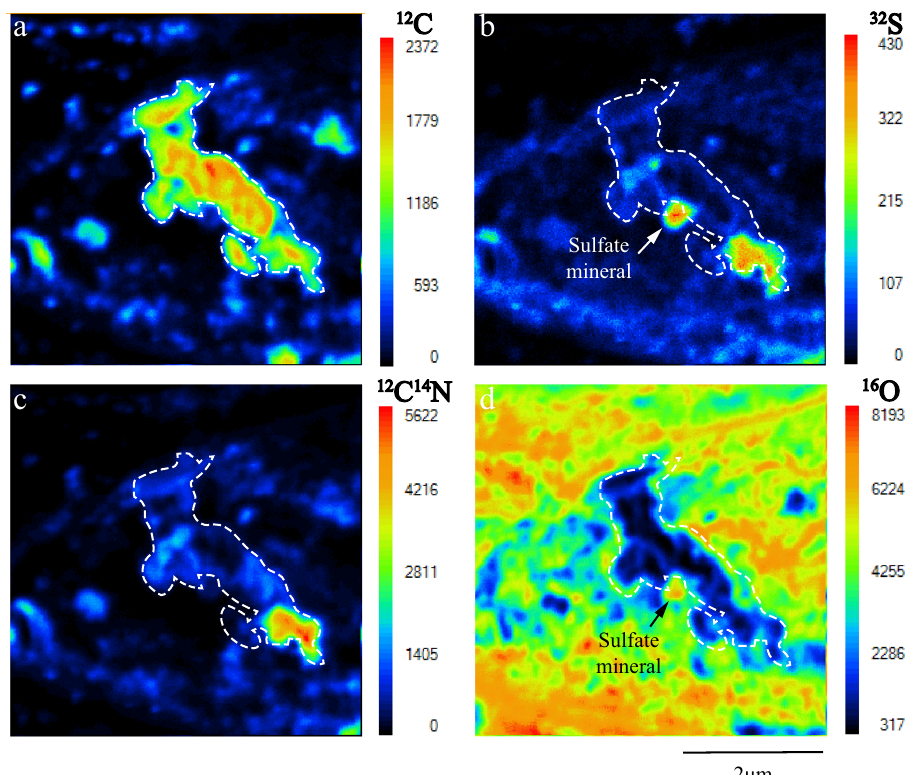
Fig. 3 Nano SIMS elemental surface analysis of disordered carbonaceous material. a – d 12 C, 32 S, 14 N, and 16 O elements distribution map of the corresponding area of the red dashed circle in Fig. 2. The disordered carbonaceous material has a low content of 16 O and is rich in 32 S and 14 N correspondingly. Meanwhile, there is also found granular sulfate mineral closely linked to carbonaceous material. The scale bar is 2 μ m.